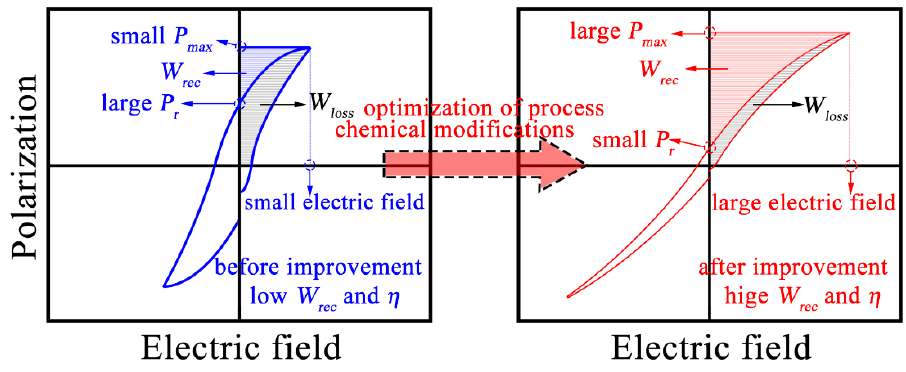
Figure 1. Schematic diagram of P-E loops for realizing superior energy-storage properties.